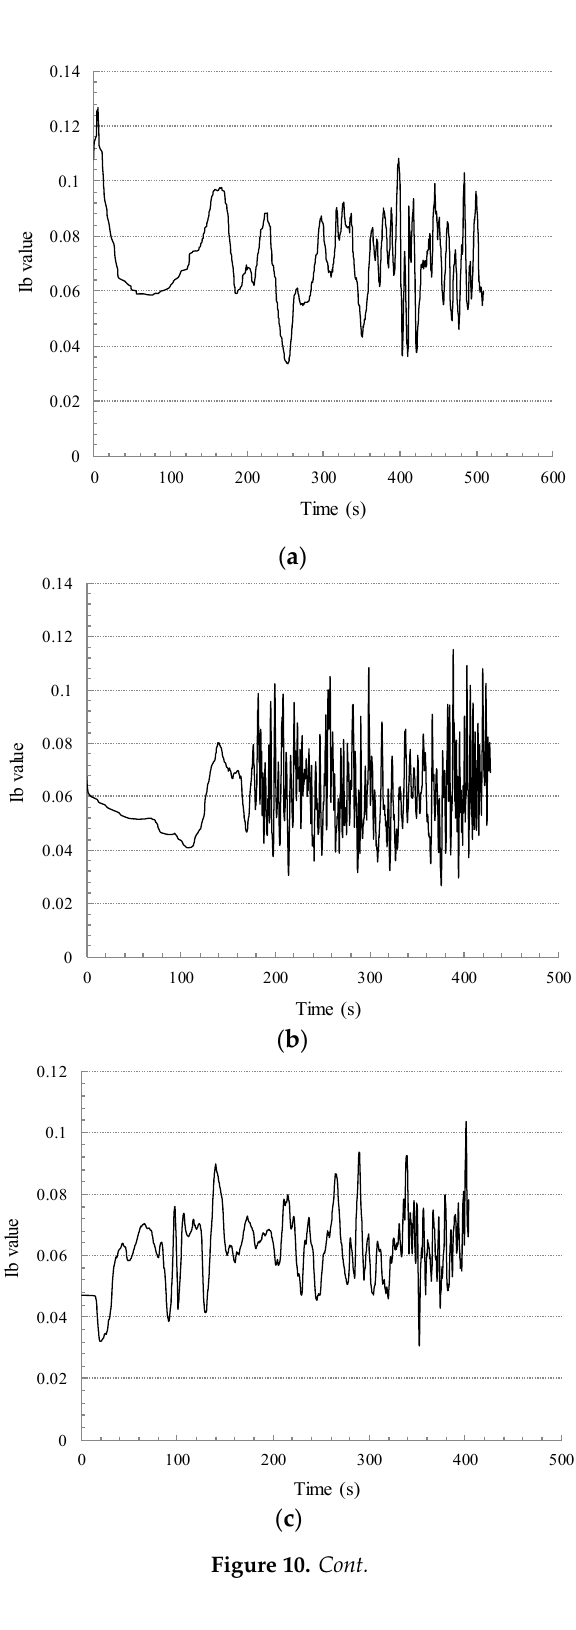
( d ) ( e ) Figure 10. Ib-value curves of corroded RC beams: ( a ) Uncorroded RC beam; ( b ) 10% corroded RC beam; ( c ) 20% corroded RC beam; ( d ) 30% corroded RC beam; ( e ) 40% corroded RC beam. From Figure 10 and Table 3, it can be considered that the maximum and minimum values of the five Ib-value curves are decreased with the increasing of the steel corrosion ratio. According to the physical meaning of the Ib-value, steel corrosion increases the proportion of the large amplitude of AE events in the fracture process, which infers that the proportion of macro-cracks is increased along with the steel corrosion ratio. Furthermore, even without loading, there are a large number of micro- cracks that form in concrete due to steel corrosion. Once the mechanical loading process begins, the